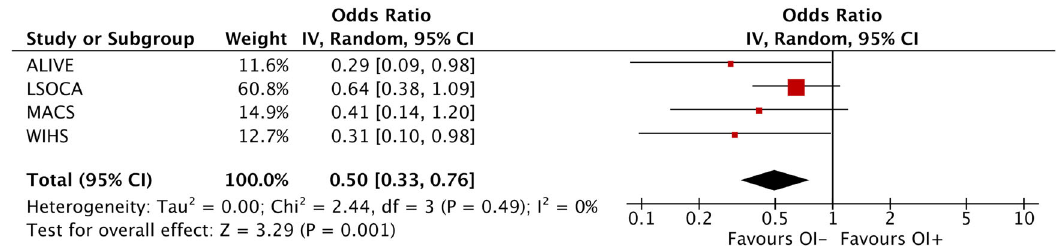
Fig. 1 Forest plot showing the odds ratios (OR) of opportunistic infection (OI) for the carriage of 2 versus 1 or 0 APOL1 variant alleles in the meta- analysis of four HIV/AIDS cohorts. Data were pooled from the four studies using inverse variance (IV) (Table 3). The red block indicates the point estimate of OR, while the horizontal line depicts 95% CI of OR in each study. The area of the block indicates the weight assigned to that study in the meta- analysis. Table 4 Association of APOL1 variant alleles with baseline AIDS-de fi ning opportunistic infections among LSOCA participants under additive and recessive genetic